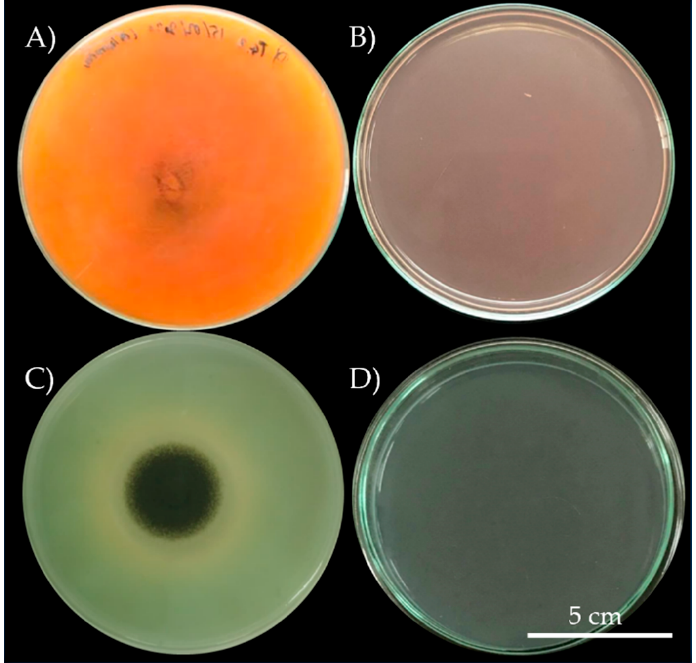
Figure 2. Biodeterioration activity of isolate Aspergillus aculeatinus ( A ) on crimson red and isolate Aspergillus piperis ( C ) on malachite green, compare with crimson red control ( B ) and malachite green control ( D ).